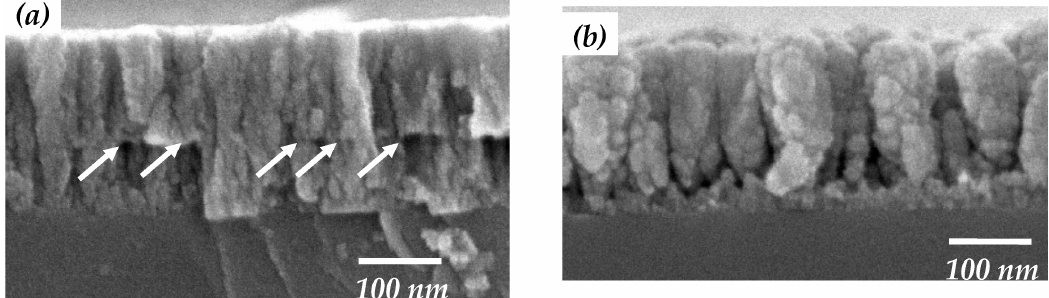
Figure 6. Cross-section images of the a-TiO x film deposited onto ( a ) untreated; and ( b ) SFE-treated base layers (the arrows in Figure 6a mark the interface of the two-step deposited a-TiO x film). FTIR spectra of the base layer with and without an additive SFE treatment and the a-TiO x films